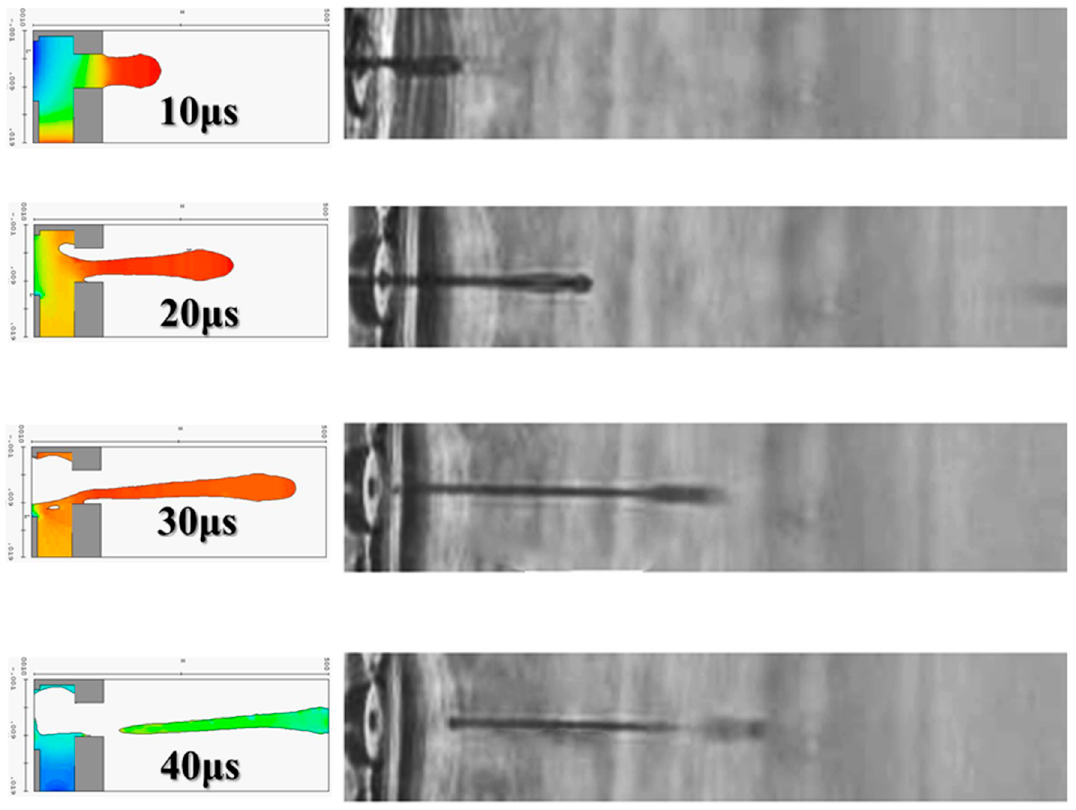
Figure 16. Droplet injection scenario and observation.